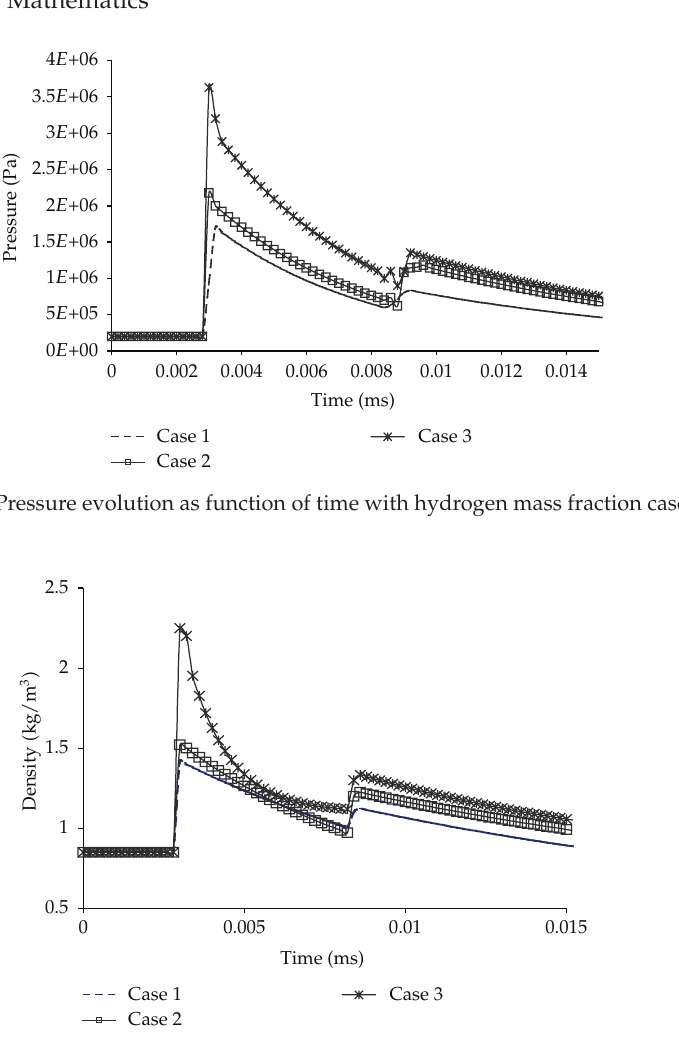
Figure 7: Density evolution for each hydrogen mass fraction in